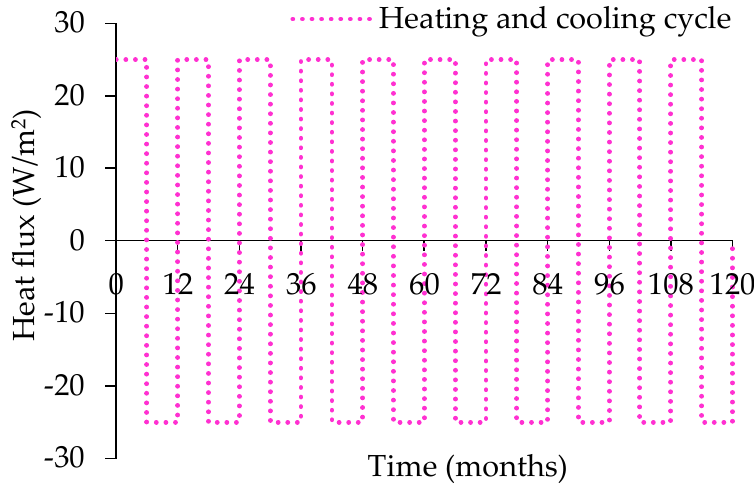
Figure 5. The cyclic heating and cooling load for 10 years duration.